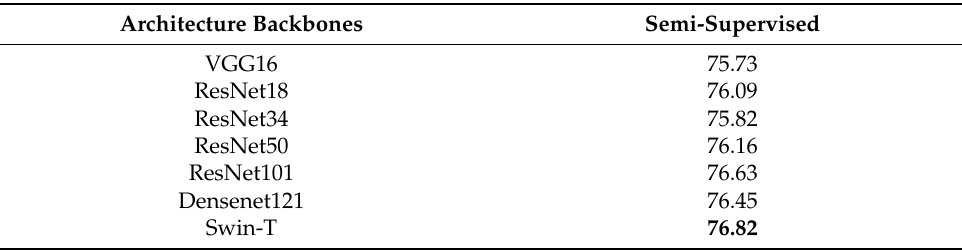
Table 4. Accuracy (%) on different backbones. For the semi-supervised method, the value is the accuracy of step 2.